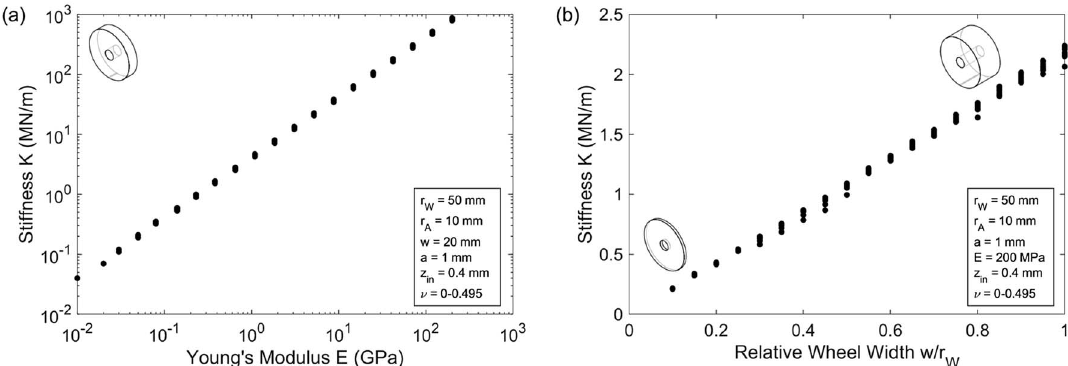
Figure 2. Results of the parametric study: (a) Young ’ s modulus E and (b) relative wheel width w = r W . Points having the same x coordinate (but a different y coordinate) are for varying values of Poisson ’ s ratio v . Schematics of the extreme wheel geometries are shown for reference (drawn to scale with respect to one another).